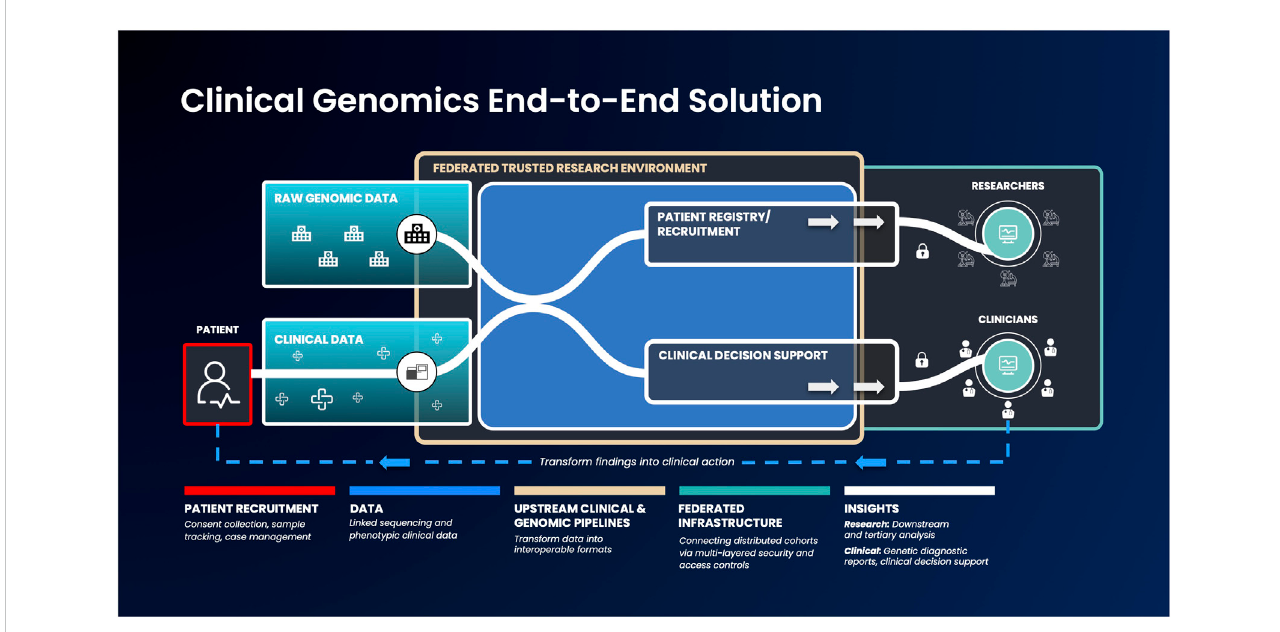
FIGURE 1 An example genomic medicine end-to-end solution that integrates federated architecture. Genomic or phenotypic clinical data is fi rst collected and transformed into interoperable formats. Next, these data will be ingested into the federated architecture, which allows authorized users to access and combine this data with other disparate sources to build unique and valuable analysis cohorts. Strict security measures will facilitate results export to clinicians and researchers, to enable them progress therapeutic discovery and make informed clinical